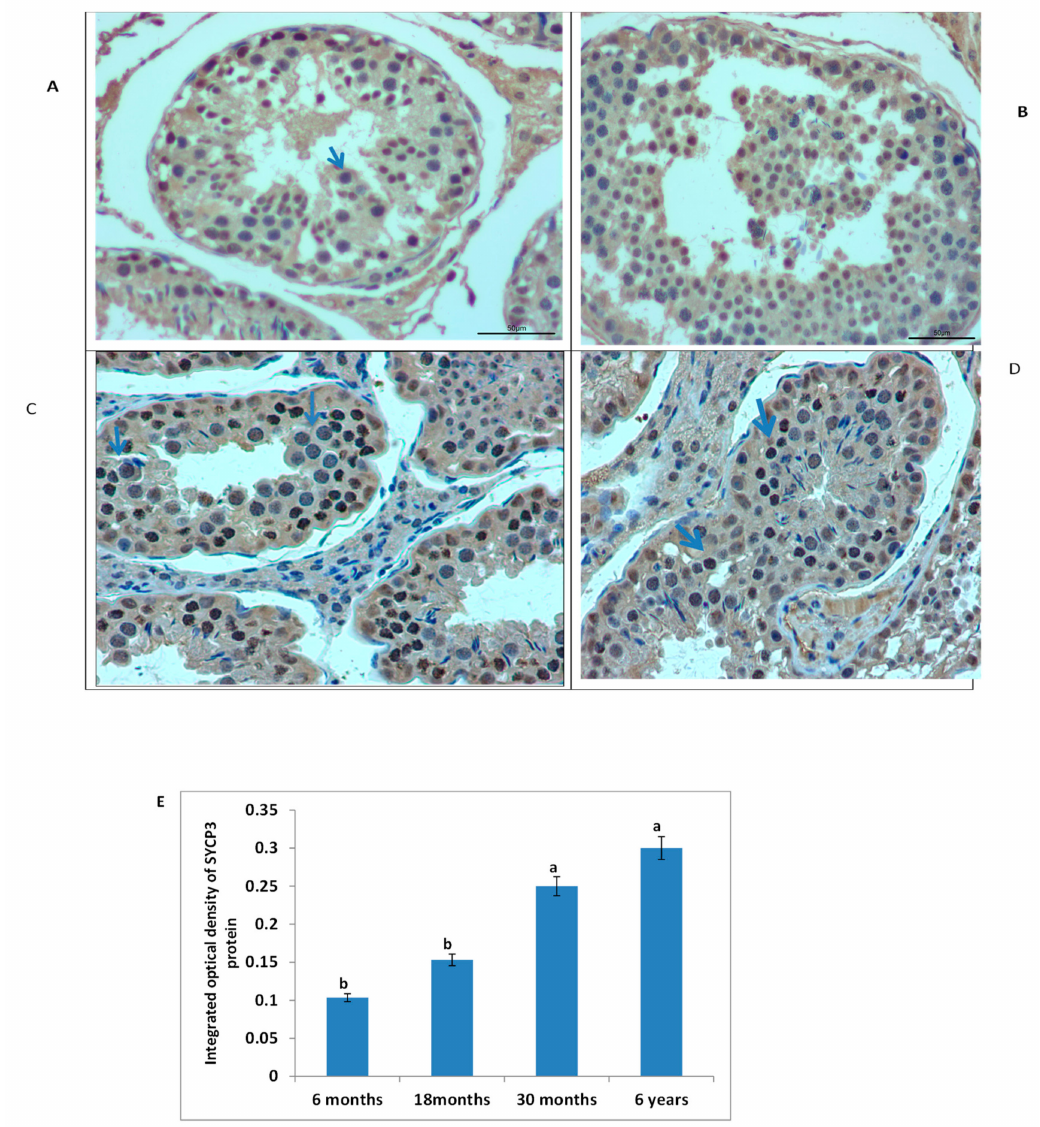
Figure 9. Immunostaining of testis of various ages of Yak. Immunostaining analysis showed that SYCP3 is present in all ages but positive cells (blue, arrow) are more abundant in 6 years and 30 months yak testis as compared to 18 and 6 months respectively. ( A ) 6 months, ( B ) 18 months, ( C ) 30 months, ( D ) 6 years. Scale bar 50 µ m. ( E ) Integrated optical density of SYCP3 protein. Di ff erent letters indicate significant di ff erence ( p <